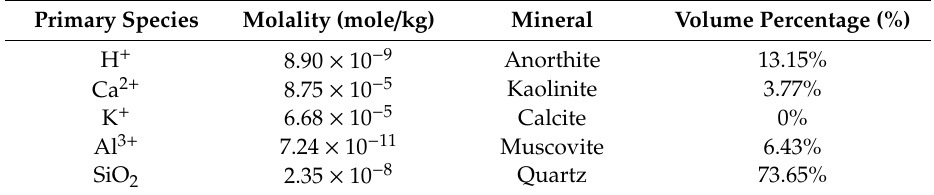
Table 3. Initial molality of the primary aqueous components of the saline at the reservoir conditions and the volume percentages of the minerals in the rock used in the simulation model.